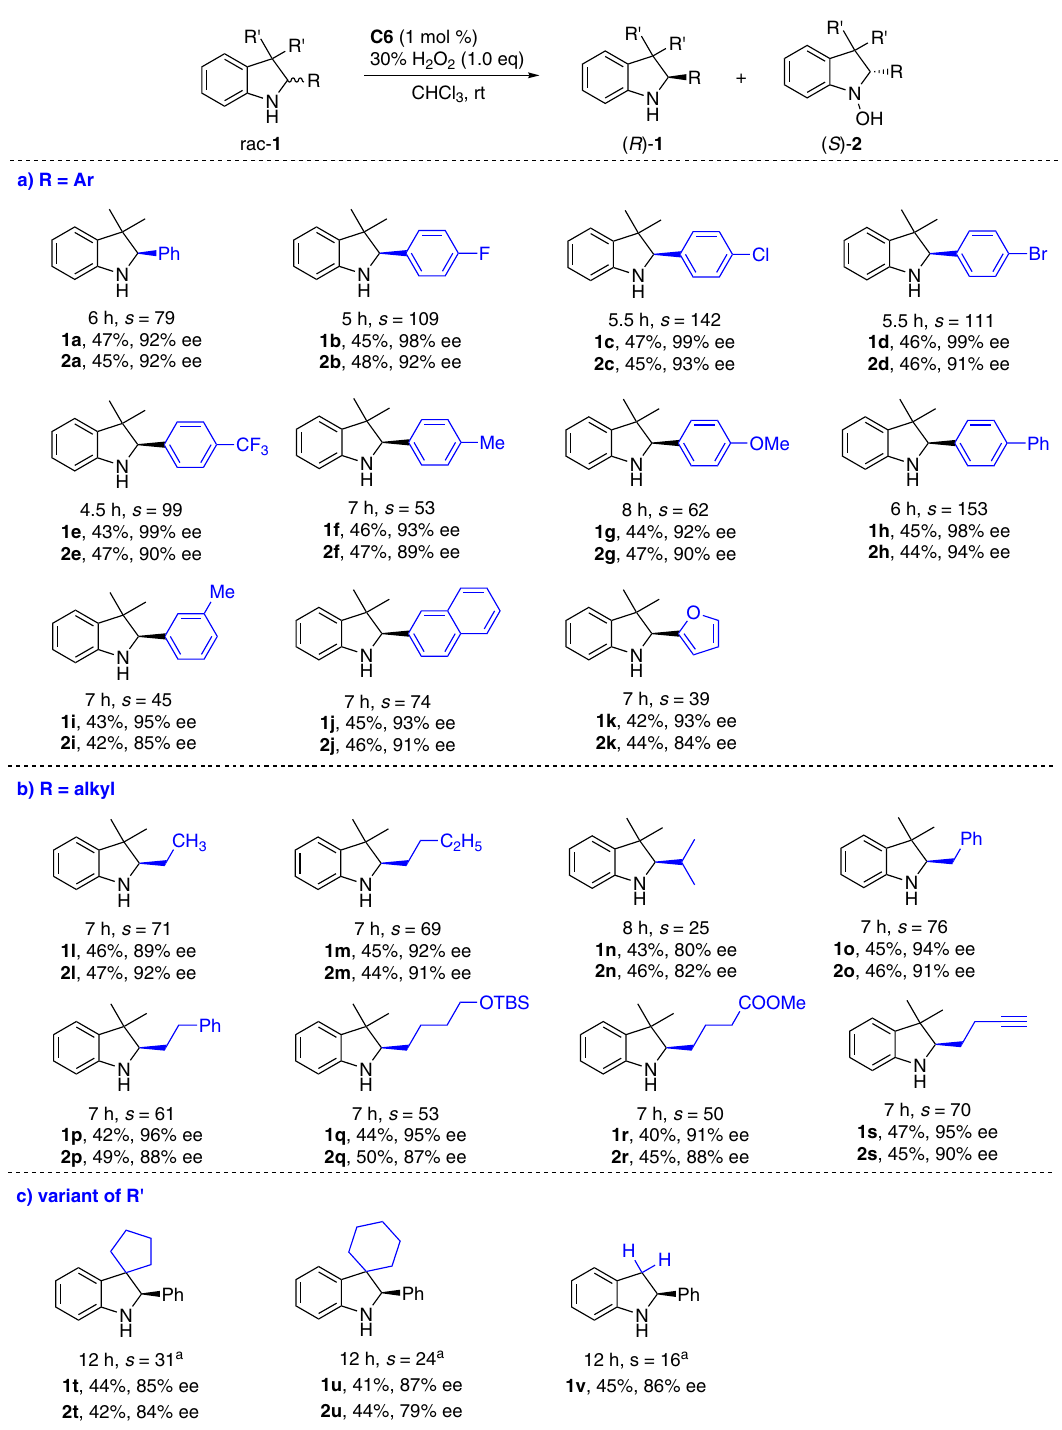
Fig. 2 Asymmetric oxygenation of racemic C 2 -substituted indolines. Conditions: rac- 1 (0.1 mmol), 30% aqueous H 2 O 2 (0.1 mmol), and C6 (1 mol %) in CHCl 3 (1.0 mL) at rt for indicated time period. a Reaction with 2.0 equiv of aqueous H 2 O 2 at 0